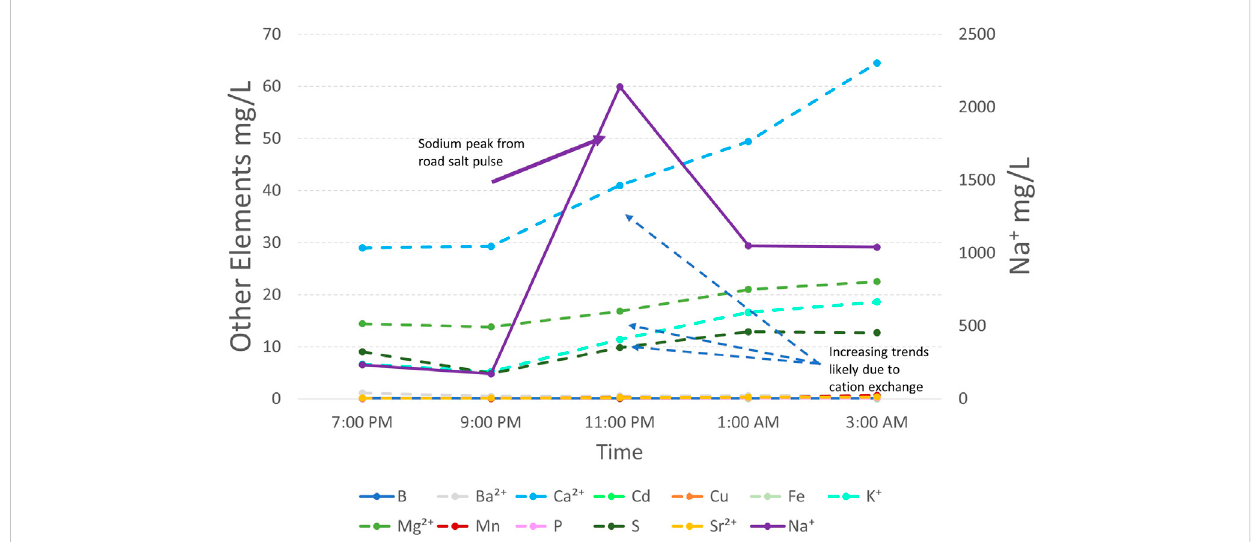
FIGURE 6 Winter storm event sampling conducted at Wetland #2 from 1/28/22 through 1/29/22. Sampling was conducted during a snowstorm where road salting occurred on the University of Maryland College Park campus. Base cation exchange is thought to drive the elemental mobilization seen after the peak Na + concentration (2140 mg/L) was